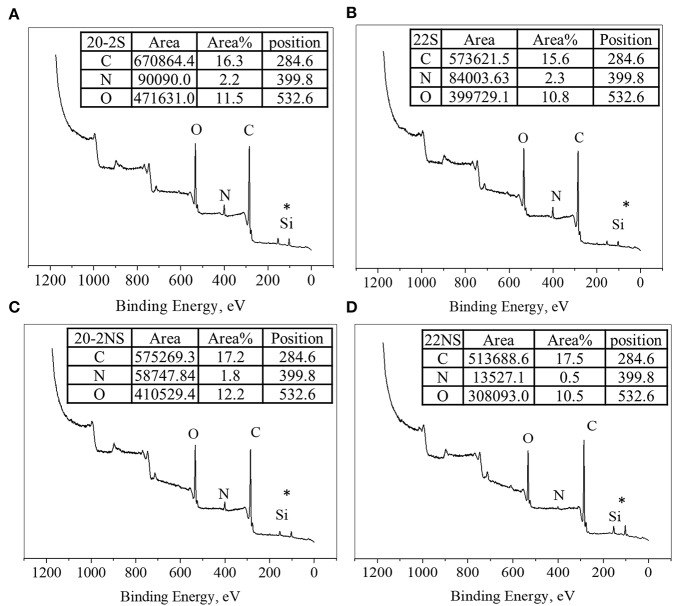
XPS survey scan of PDA-coated PP mesh for 20-2S (A), 22S (B), 20-2NS (C), and 22NS (D). *Si peak is attributed to the SiO2 surface of the sample holder.